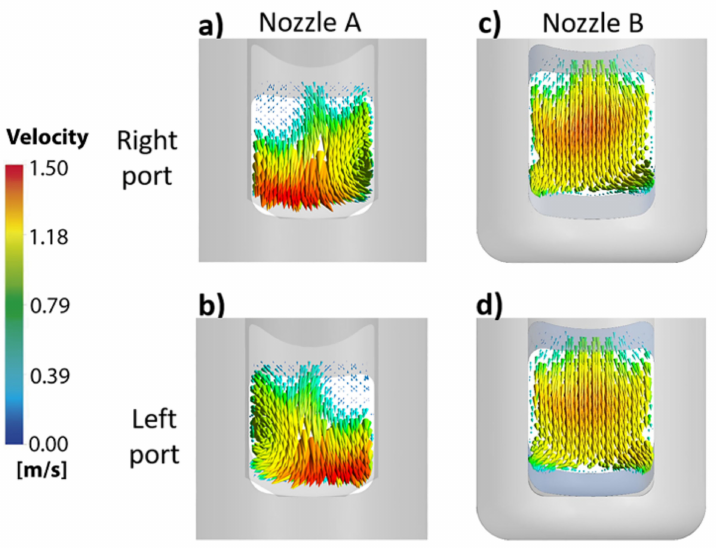
Figure 16. Flow through the ports of the nozzles without clogging. ( a ) Nozzle A, right port. ( b ) Nozzle A, left port. ( c ) Nozzle B, right port. ( d ) Nozzle B, left